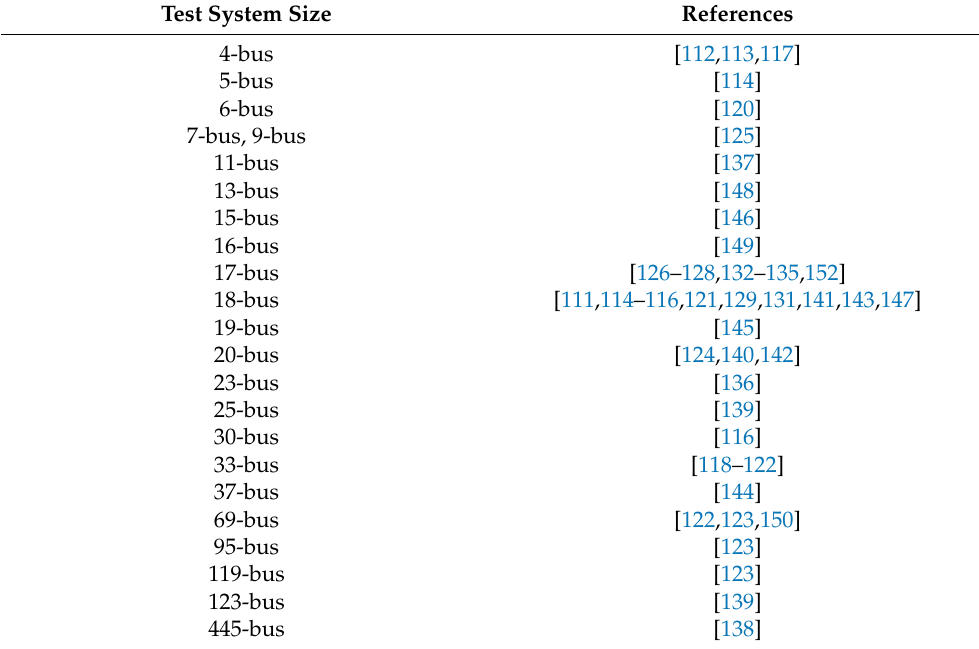
Table 3. Used test system sizes. Test System